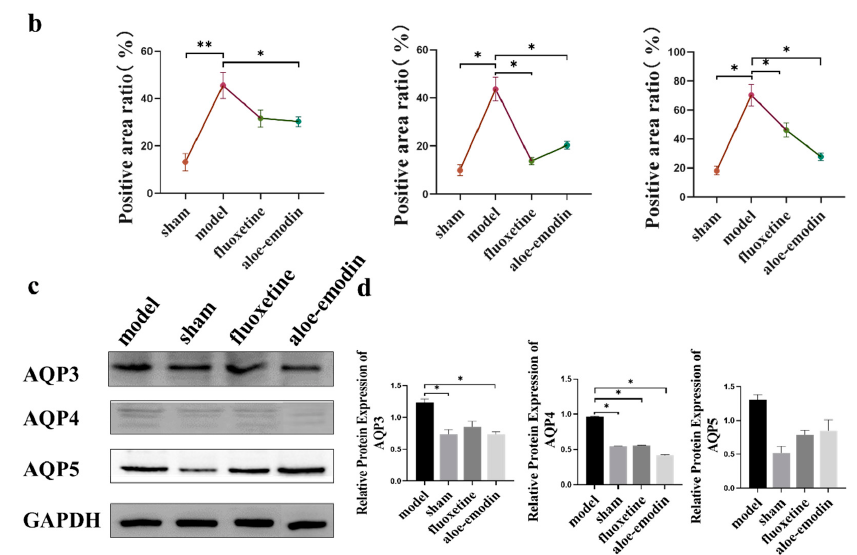
Figure 3. ( a ) Immunohistochemical detection of AQP3, AQP4, and AQP5 expressions in brain tissue; ( b ) quantitative analysis of immunohistochemistry (n = 3); ( c ) WB detection of AQP3, AQP4, and AQP5 protein expressions in brain tissue; ( d ) quantitative analysis of AQP3, AQP4, and AQP5 protein expressions in brain tissue by WB (n = 3). (** p < 0.01) (* p < 0.05).